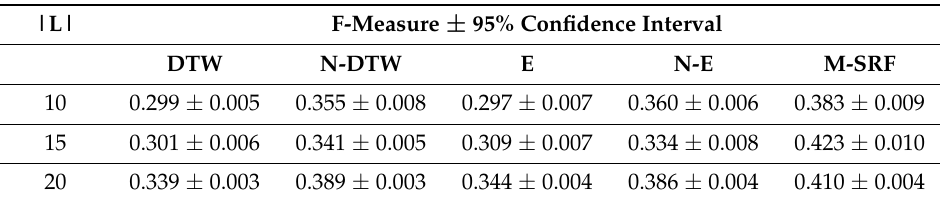
Table 1. Performance of the M-SRF and the DTW